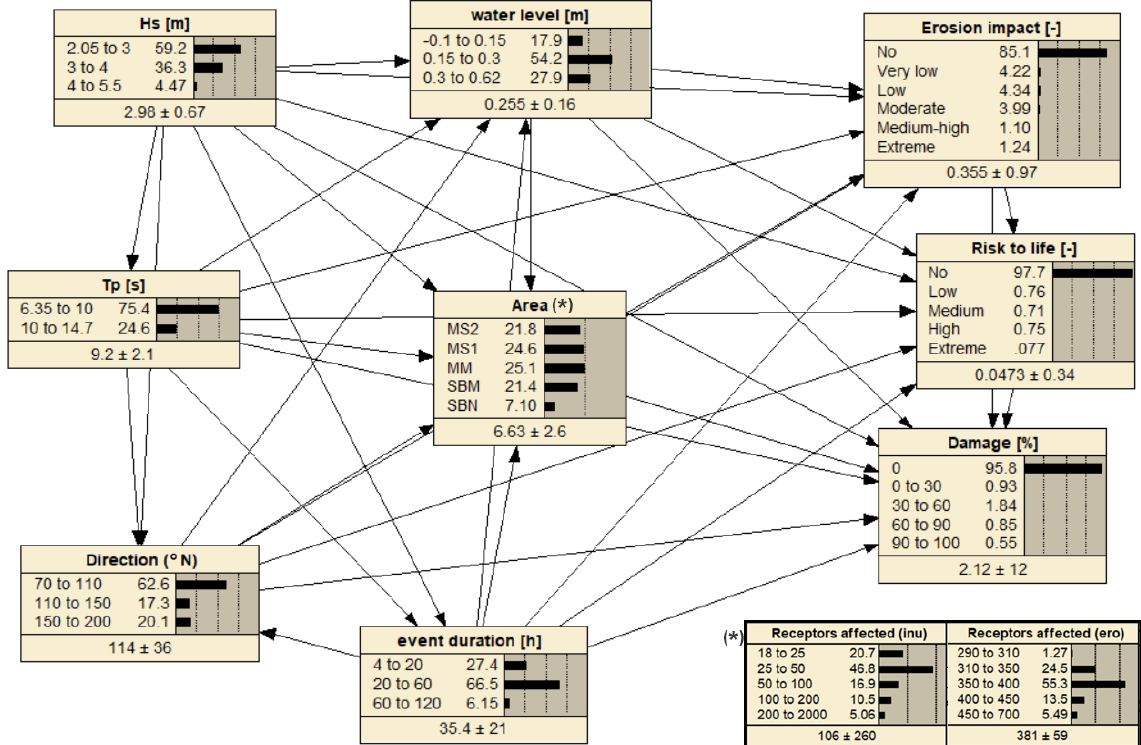
Figure 6. BN-A, linking source variables to consequences. The central variable ( ∗ ) is used for conditioned assessments and is one of three: (i) total number of affected receptors by inundation within a storm event; (ii) total number of affected receptors by erosion within a storm event, and (iii) receptor area (i.e, SBN, SBM, MSM, MS1, and MS2). Distributions correspond to the baseline